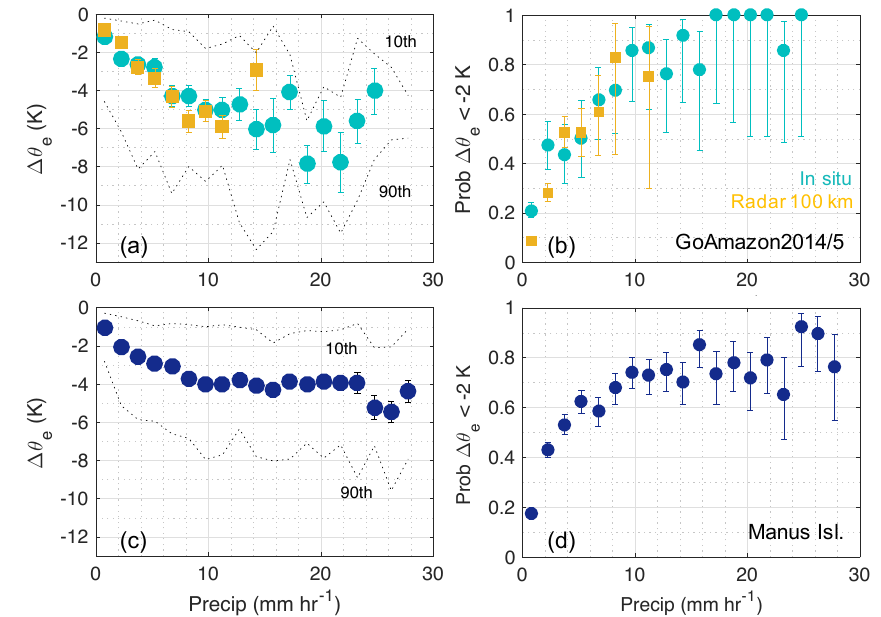
Figure 9. (cid:49)θ e conditionally averaged by coincident precipitation (1h averages) at the GoAmazon site (a, b) and at Manus Island (c, d) . Precipitation values corresponds to the θ e values at the end of each differencing interval. Bins are a width of 1.5mm hr − 1 . Error bars represent the standard error (a, c) , and the 10th and 90th percentile values for each bin are drawn for reference (b, d) . Error bars on the probability represent Wilson score intervals from 5 to